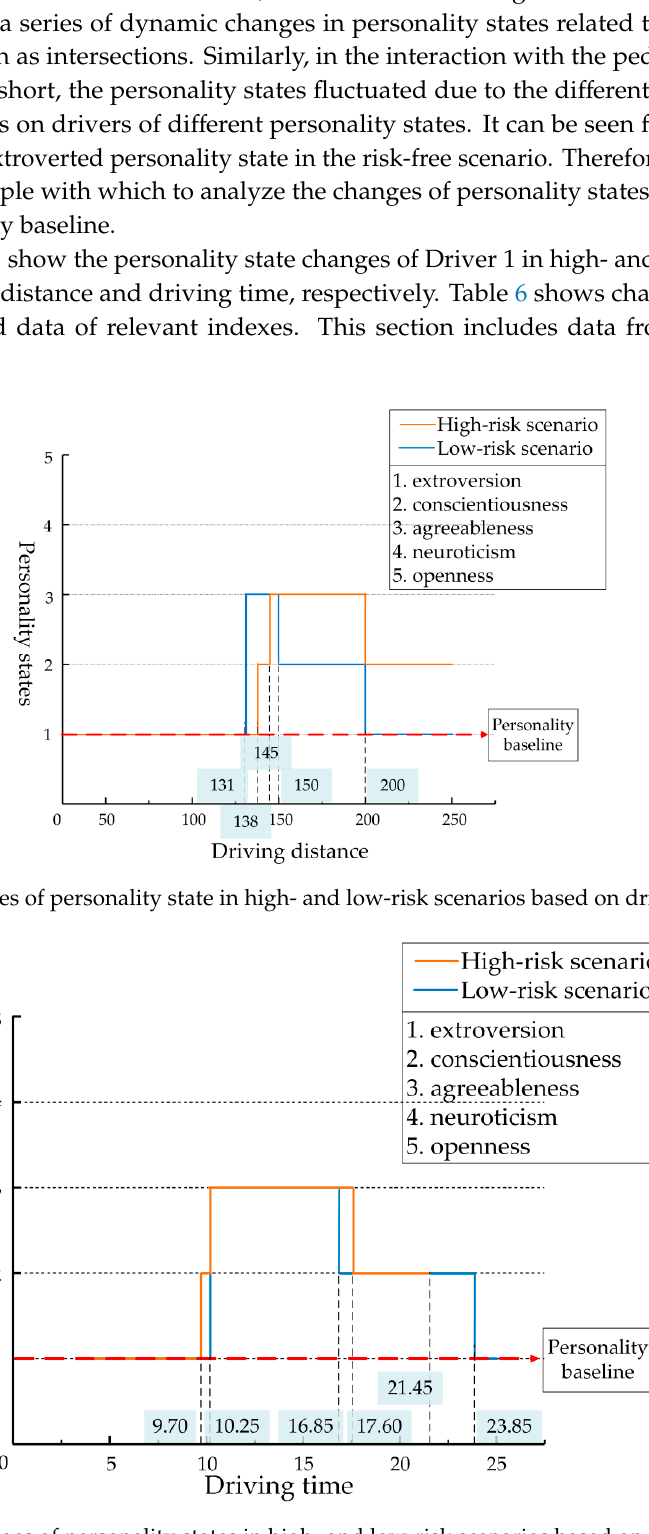
Figure 11. Changes of personality states in high- and low-risk scenarios based on driving time.